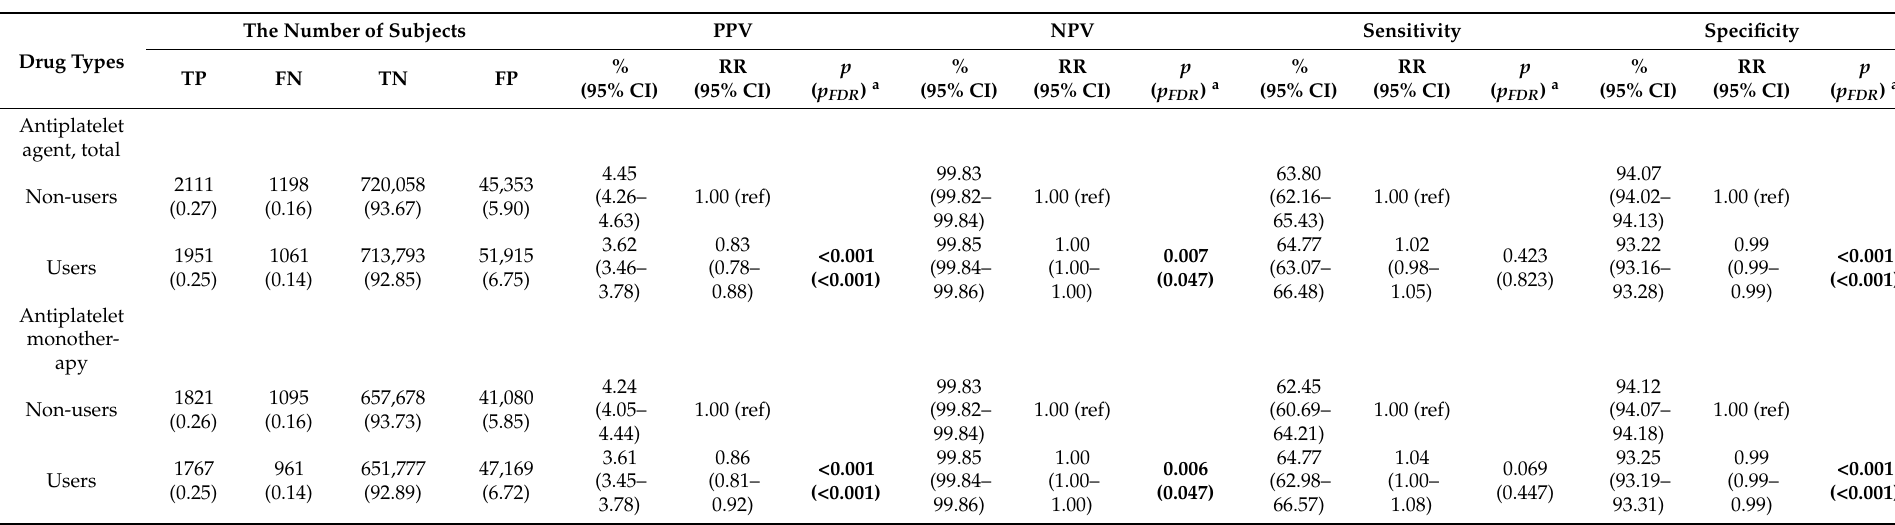
Table 3. Diagnostic performance of FITs for detecting CRC according to the use of antithrombotic agents in the 1:1 matched